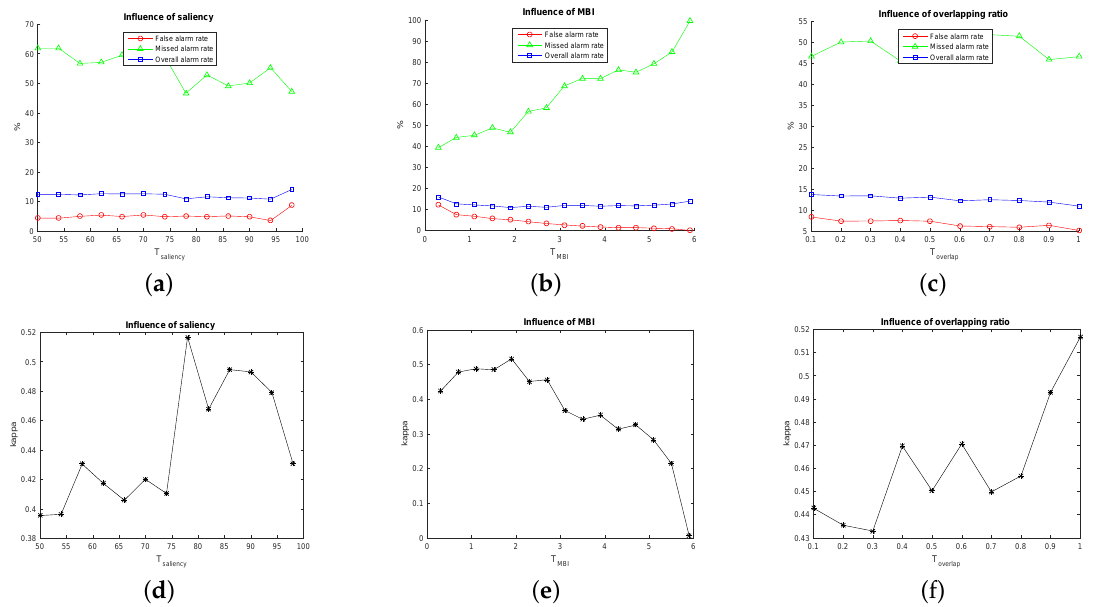
Figure 5. Sensitivity delineation of the parameters for the first image pair. ( a ) Influence of saliency on FAR, MAR and OAR; ( b ) influence of MBI on FAR, MAR and OAR; ( c ) influence of overlapping ratio on FAR, MAR and OAR; ( d ) influence of saliency on kappa ; ( e ) influence of MBI on kappa ; ( f ) influence of overlapping ratio on kappa .